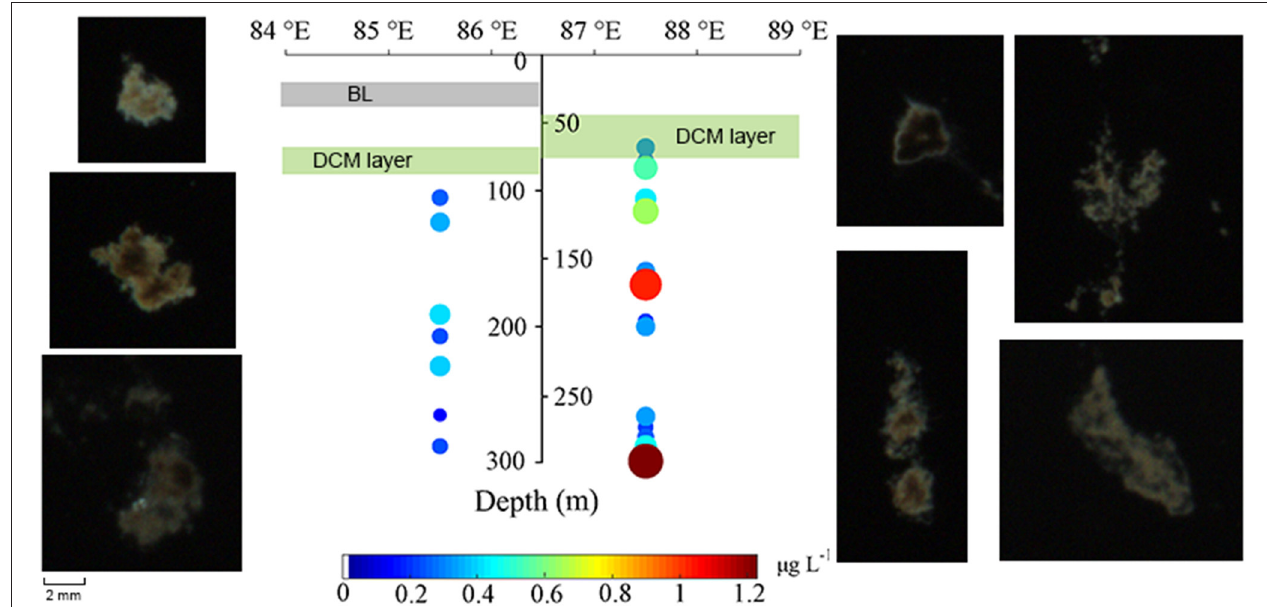
FIGURE 6 | Vertical distribution of detritus abundance in carbon concentration in the upper 300m at the BL-affected station and the unaffected station. The BL and DCM layers were shown by shaded gray and lime, respectively, as the same as those in Figure 5 . Photos of detrital particles were extracted from the sampling